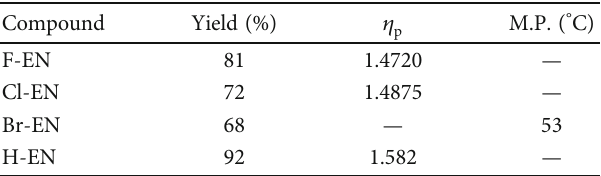
Table 1: Yields, melting points (M.P.), and refractive indices ( η for the synthesized β